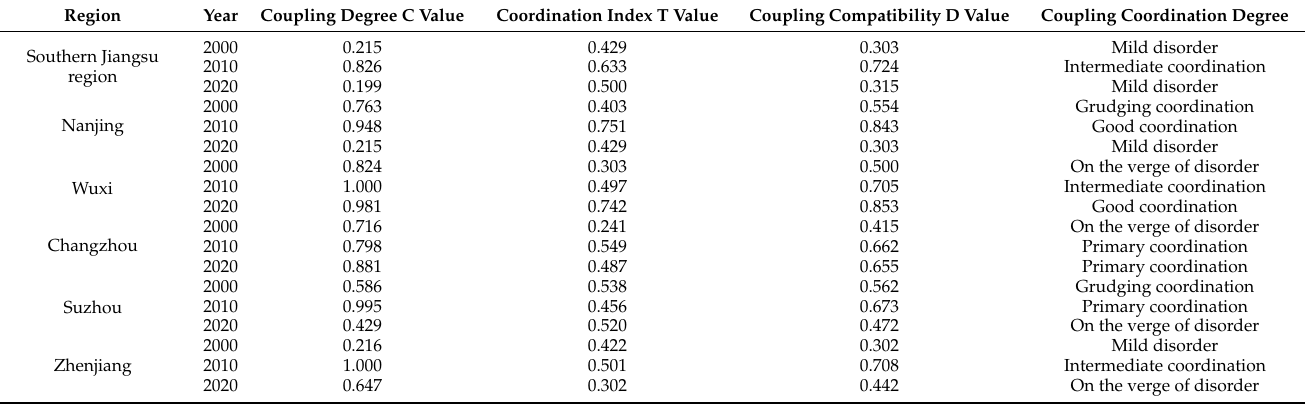
Table 6. Coupling and coordination degree of tourism economy and ecosystem service value in southern